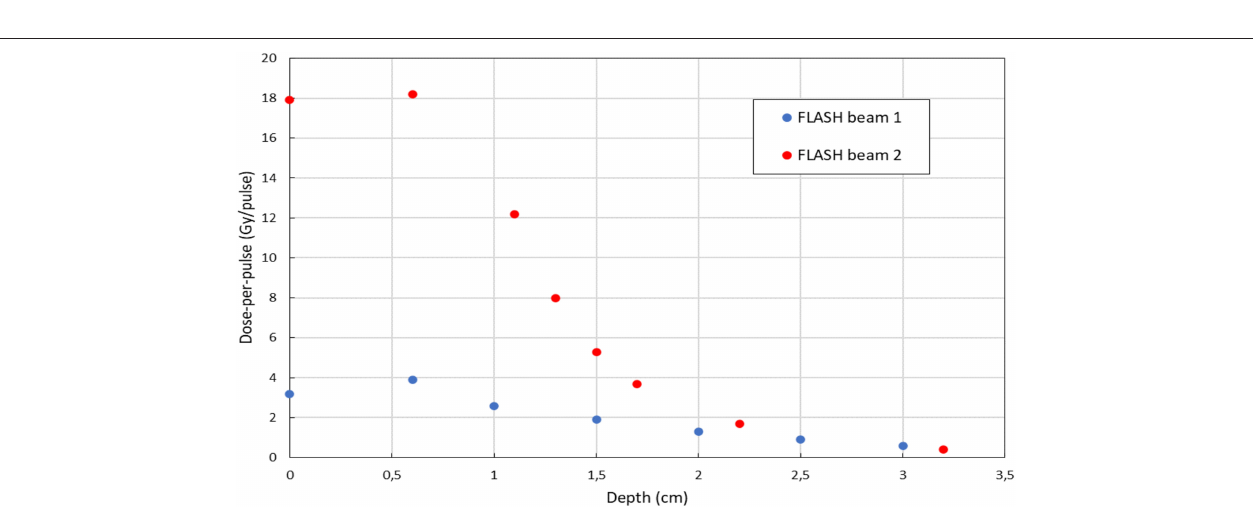
FIGURE 9 | Depth-dose distribution of electrons measured in a plastic phantom with EBT3 in FLASH beam 1 mode (blue) and FLASH beam 2 mode (red).